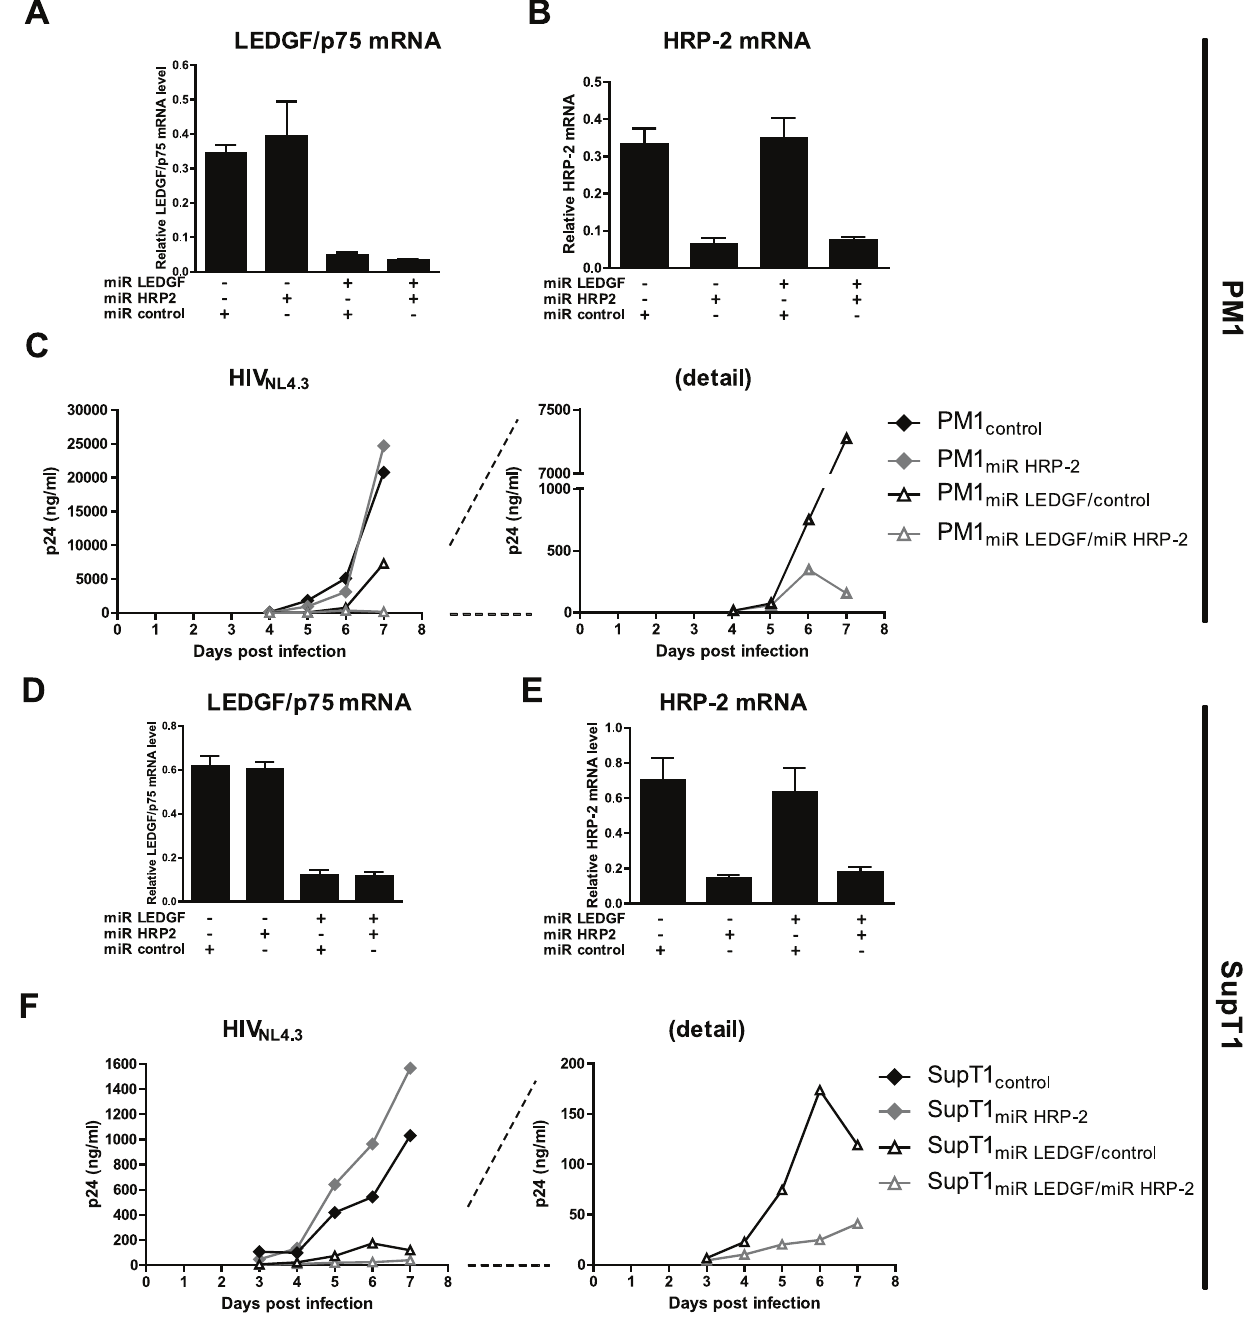
Figure 4. HRP-2 KD additionally hampers HIV-1 replication in LEDGF/p75 KD cell lines. Stable LEDGF/p75 and/or HRP-2 KD and control PM1 and SupT1 cells were generated. In (A) qPCR results for LEDGF/p75 and (B) HRP-2 mRNA expression levels, normalized to RNaseP for PM1 are shown. Average with standard deviations from experiments in triplicate, are shown. The constructs used, are shown below the graph. (C) Multiple round HIV-1 replication after challenge with the laboratory strain HIV NL4.3 . On the right a detail panel for LEDGF/p75 KD cells is shown. In (D) LEDGF/ p75 and (E) HRP-2 expression levels in SupT1 cells, analogous to (A) and (B) are shown. (F) Multiple round HIV-1 replication in the different SupT1 cells, analogous to (C), is